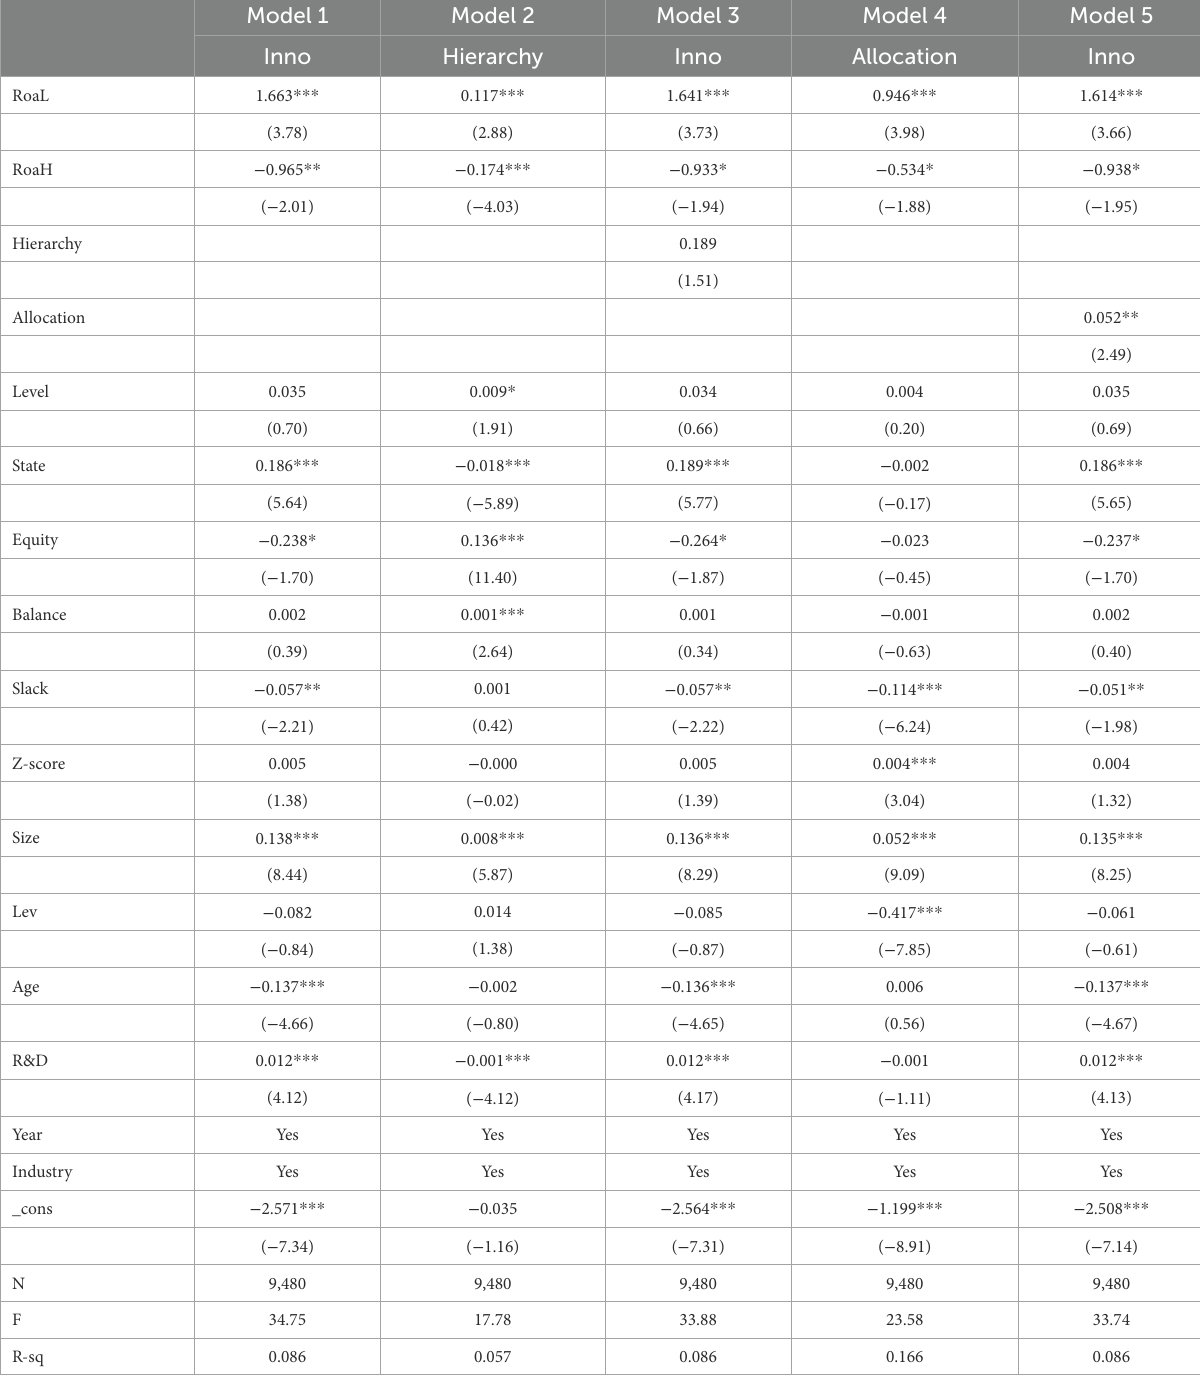
TABLE 6 Results of the tests for the alternative variables of parent